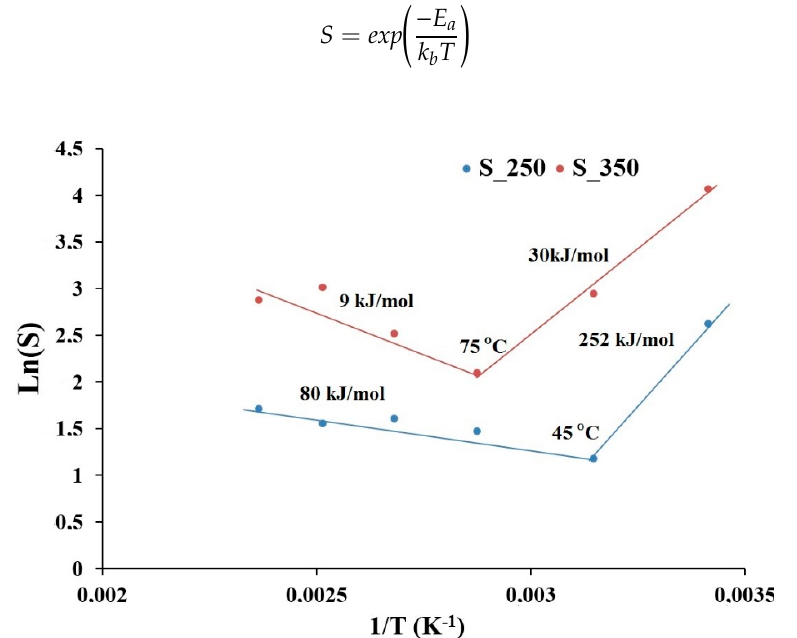
Figure 8. Ln(S) vs. 1/T plots are used to determine the activation energy.